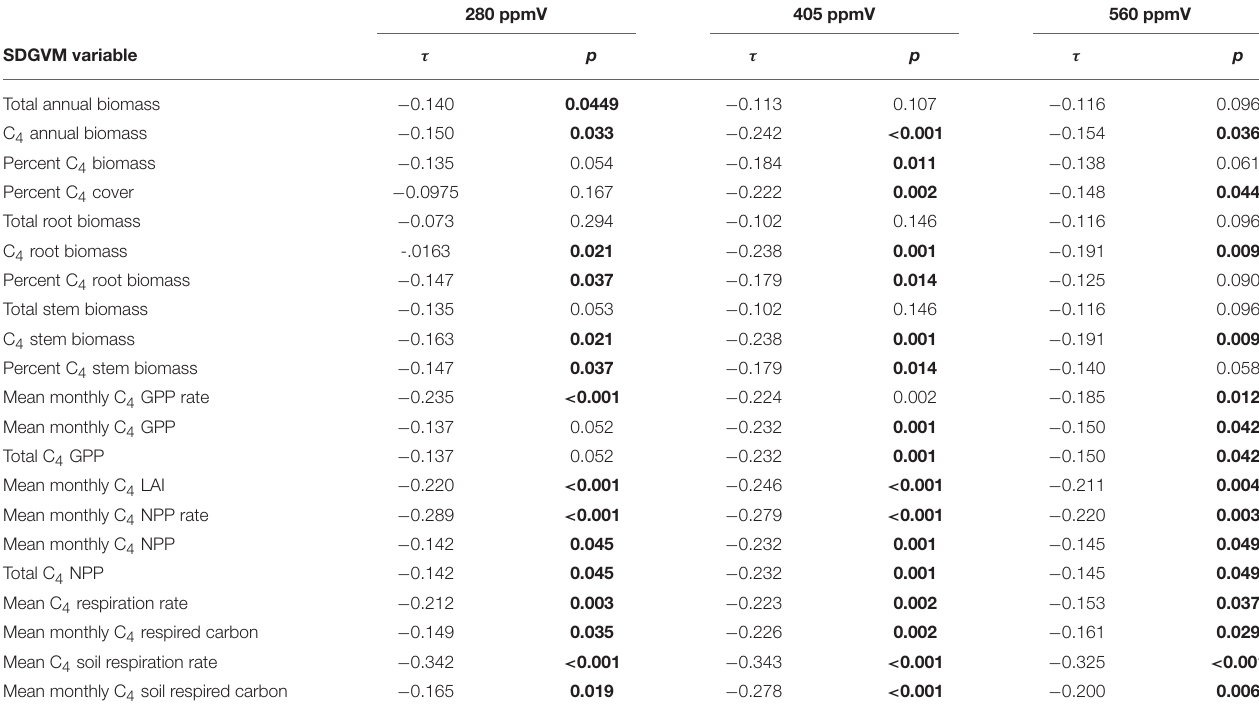
TABLE 2 | Kendall’s rank correlation coefficients ( τ ) and p -values for comparisons of estimates of mean percent C 4 biomass from δ 13 C-values of Pliocene paleosol carbonate with results of three cases of the